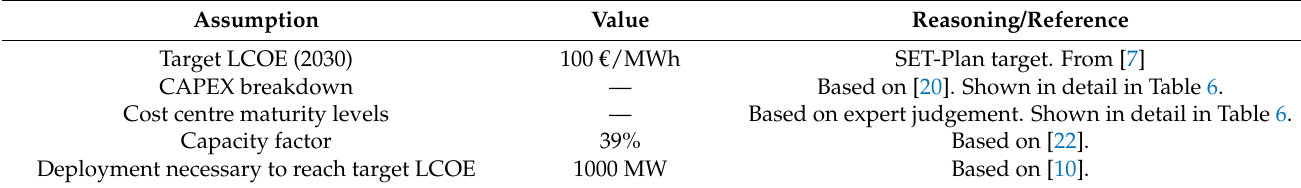
Based on expert judgement. Shown in detail in Table 6. Based on